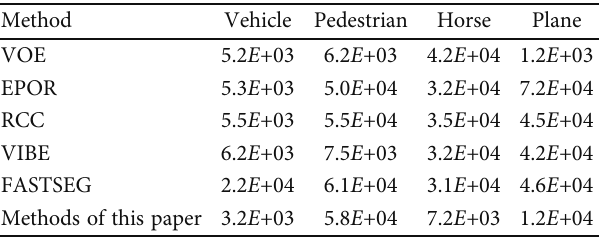
Table 3: Accuracy comparison results of di ff erent segmentation methods on data